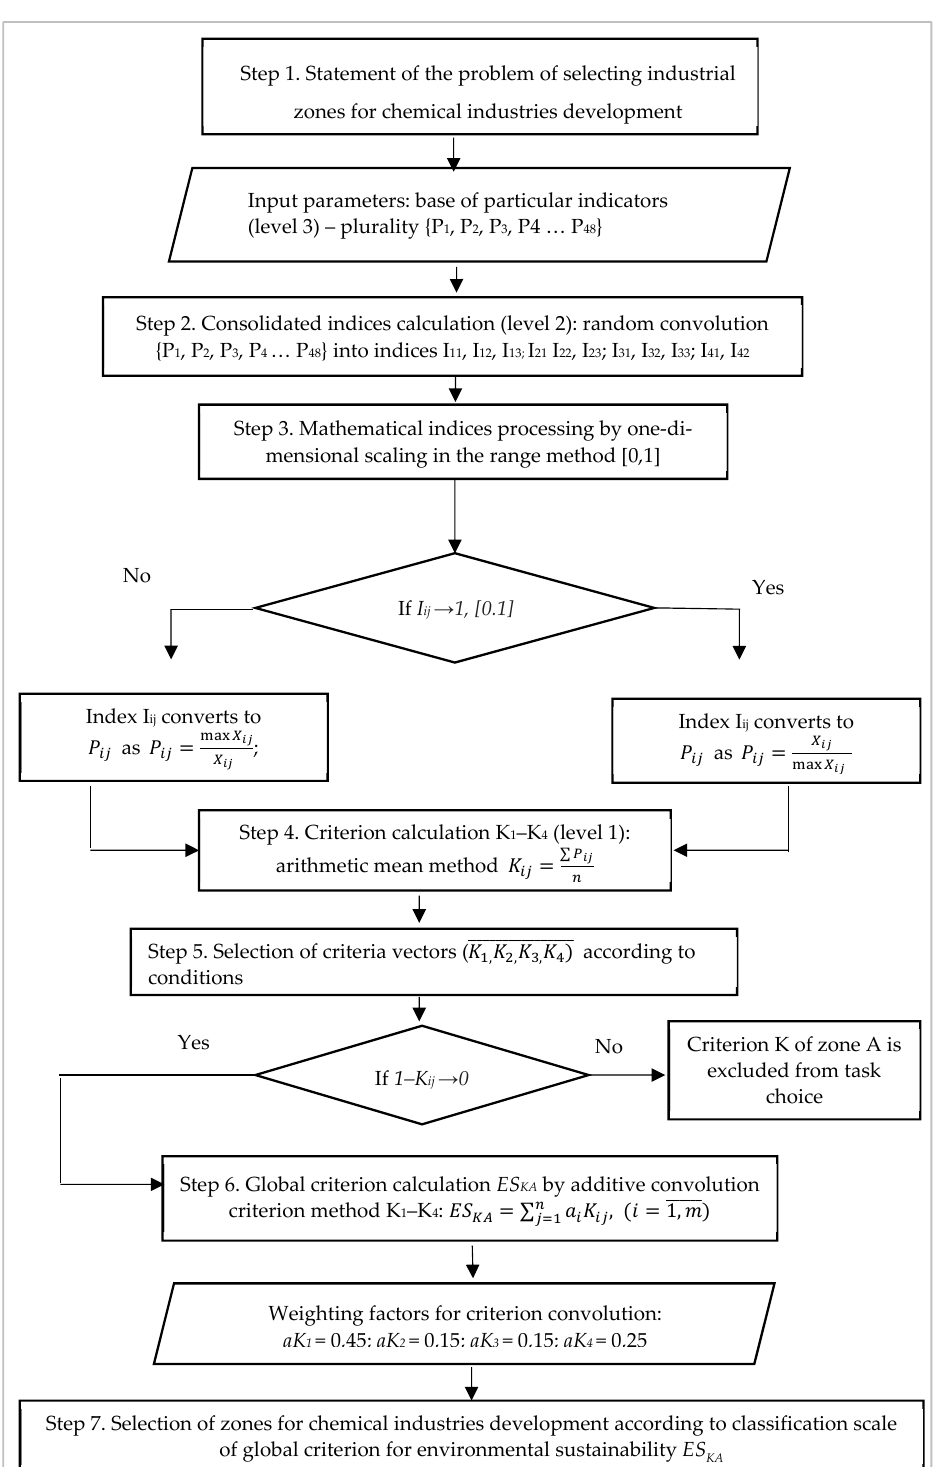
Figure 1. Algorithm for solving the multicriteria problem of choosing industrial zones for chemical industries development using the additive global criterion method.